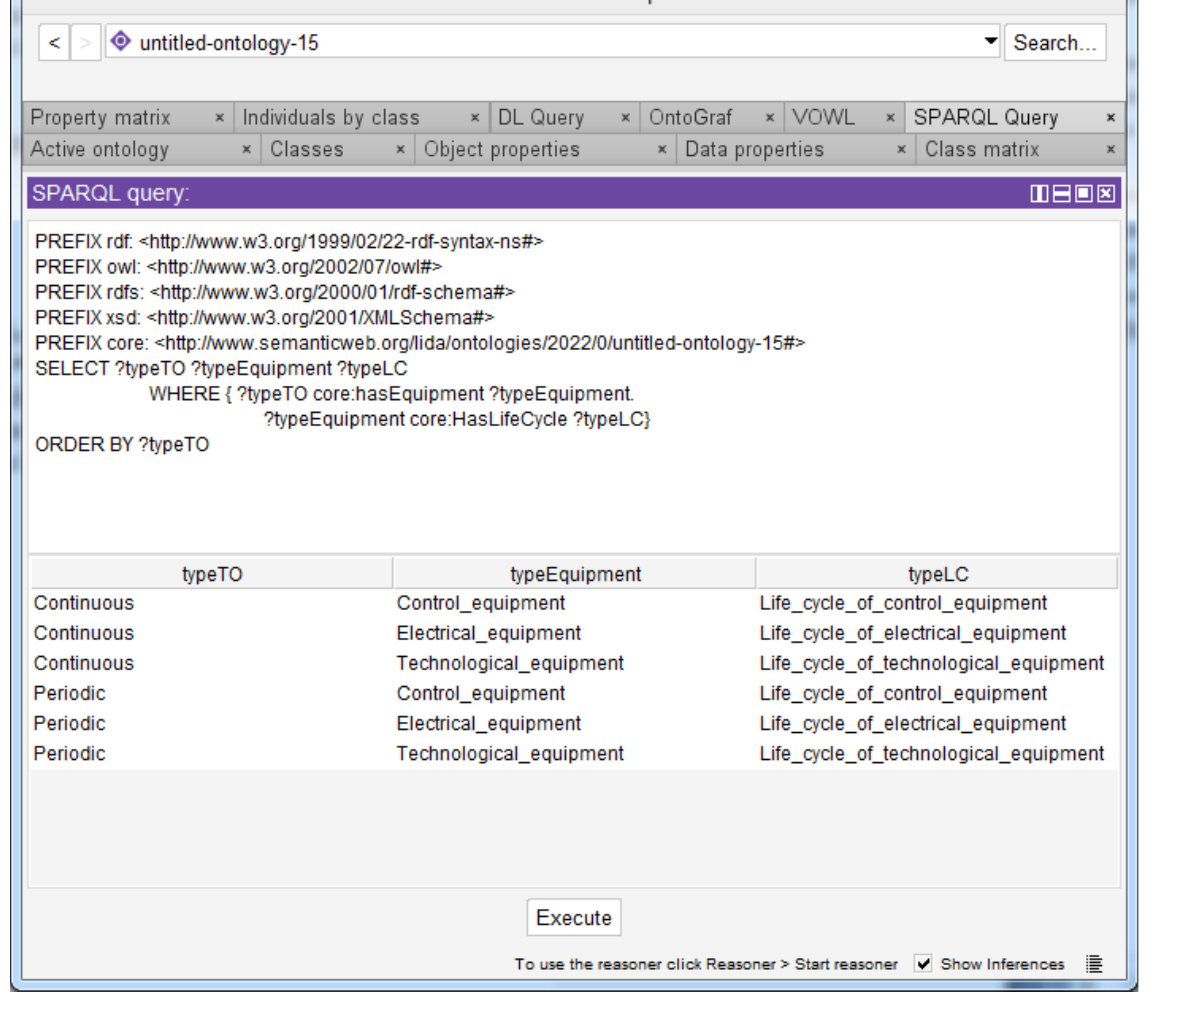
Figure 5. Query 1.